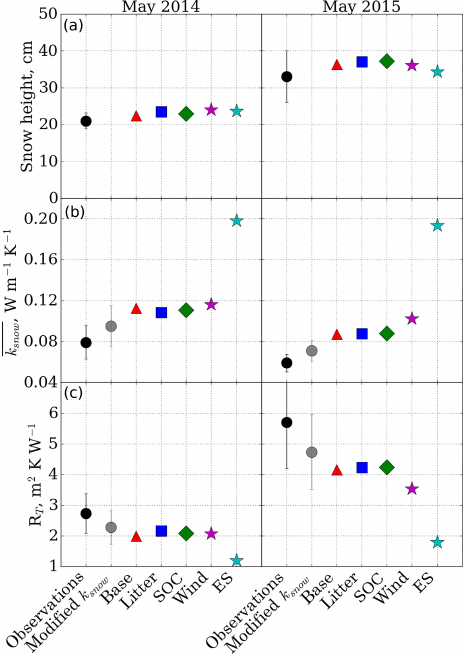
Figure 7. Overview of snow height (a) , mean thermal conductiv- ity (b) and thermal insulance (c) measured during May 2014 and 2015 field campaigns along with simulated